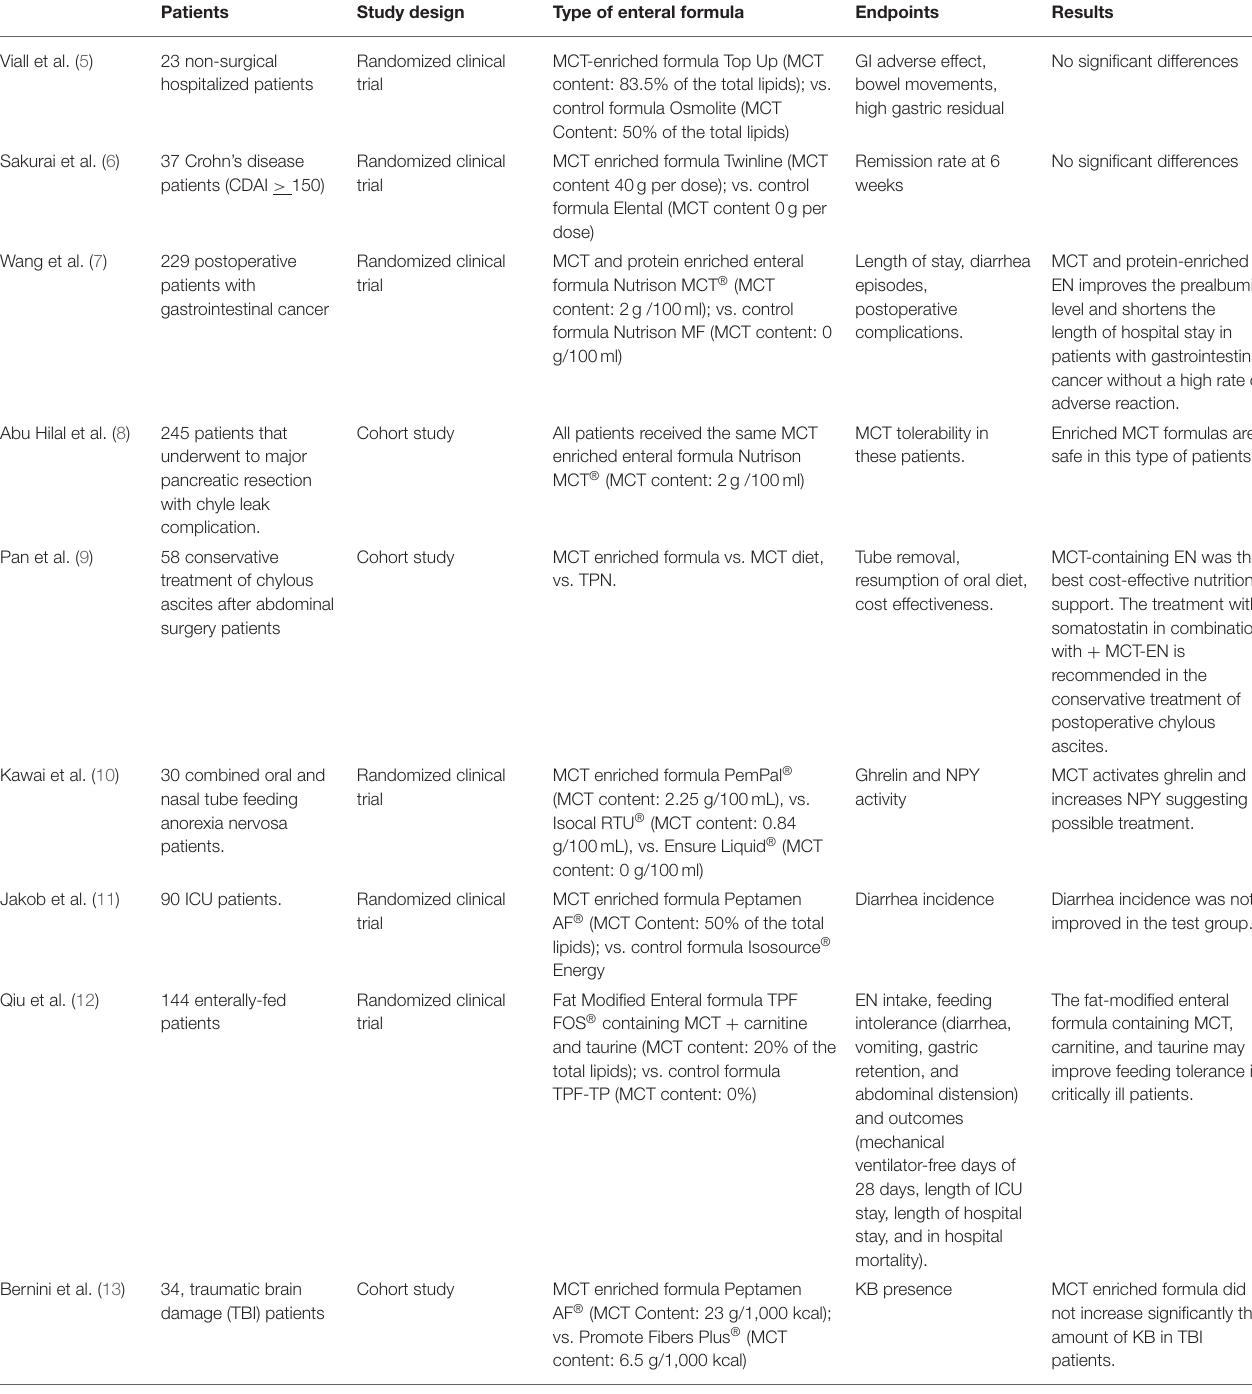
TABLE 1 | Clinical studies included in the systematic review evaluating the effects of MCT-enriched enteral nutrition on clinical